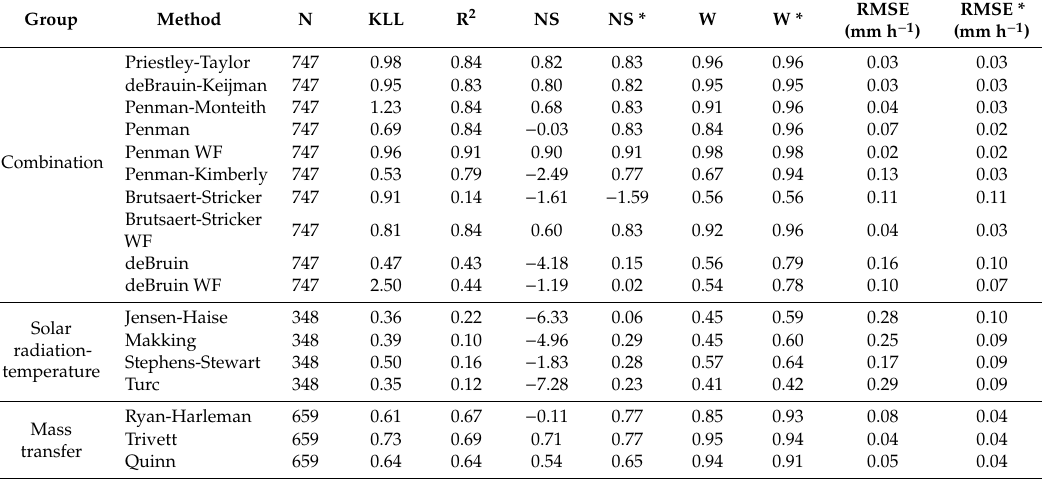
Table 7. Statistical indicators prior to and after the application of adjustment parameters for the Laja Lake ( K LL ) (* indicates that the displayed factor is the one obtained after applying K LL